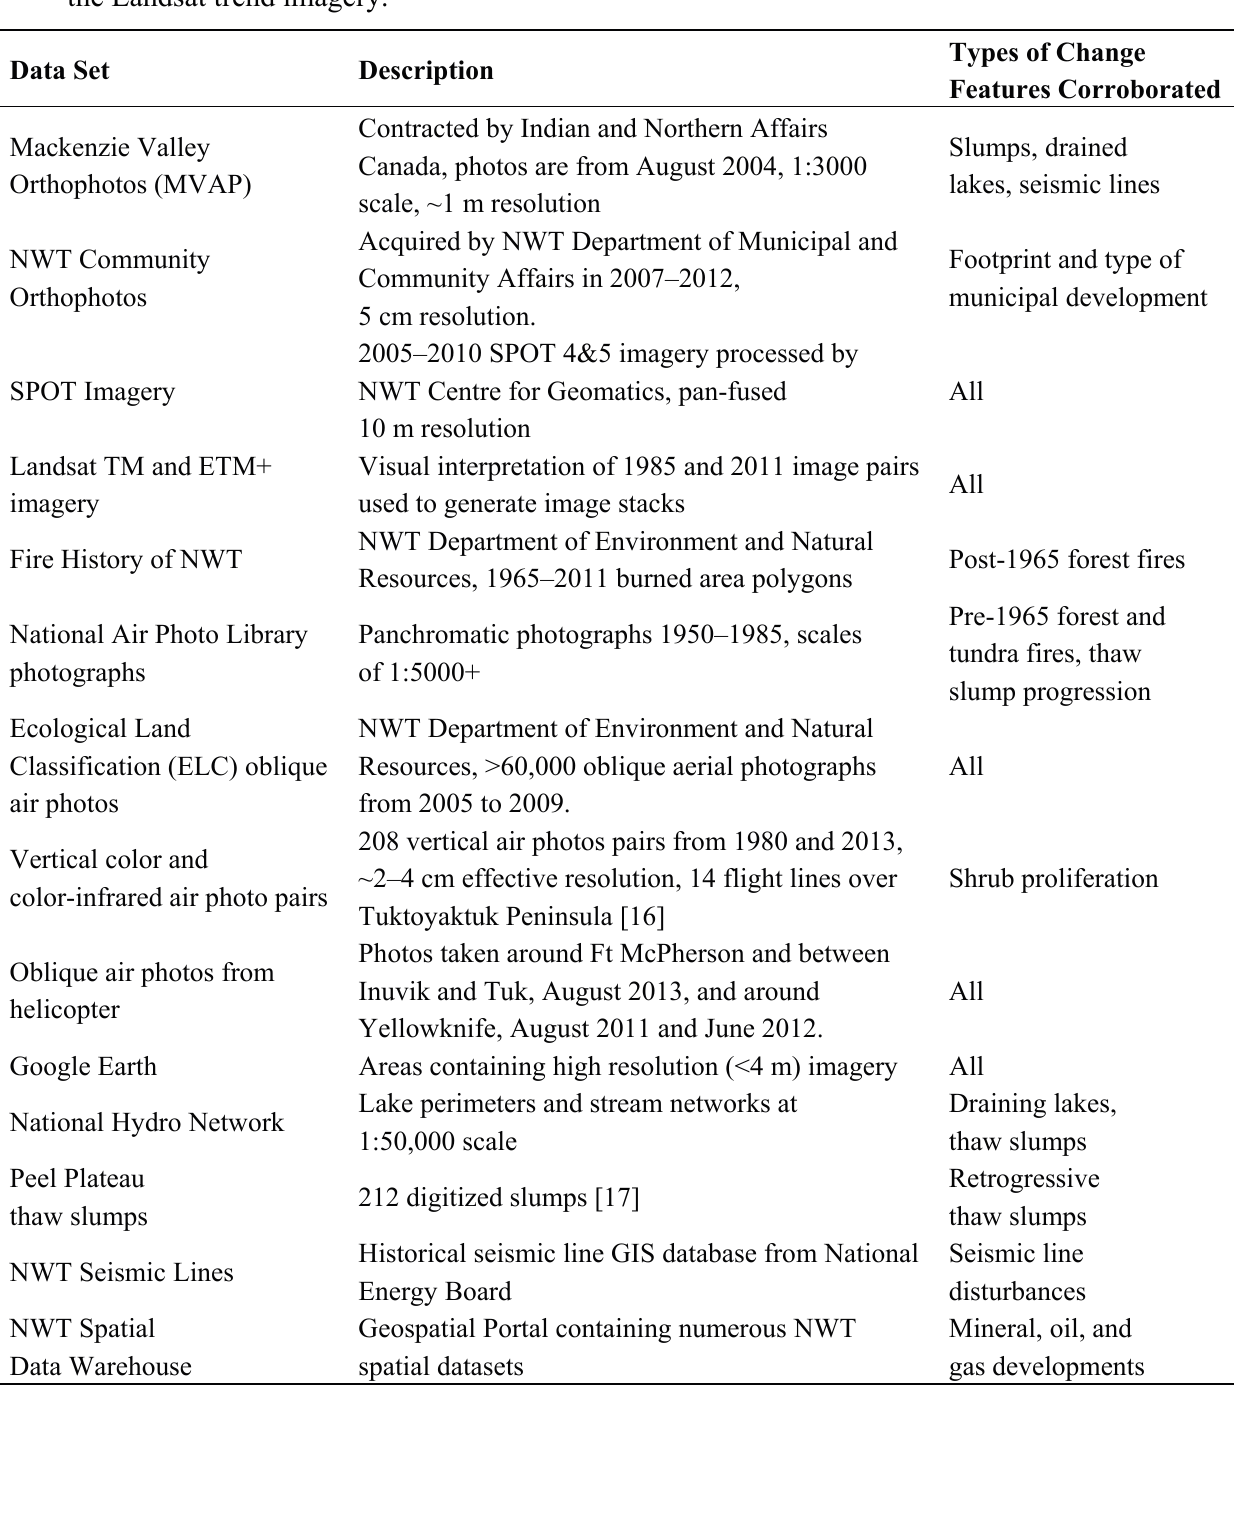
Table 1. Reference data used to identify and corroborate landscape changes observable in the Landsat trend